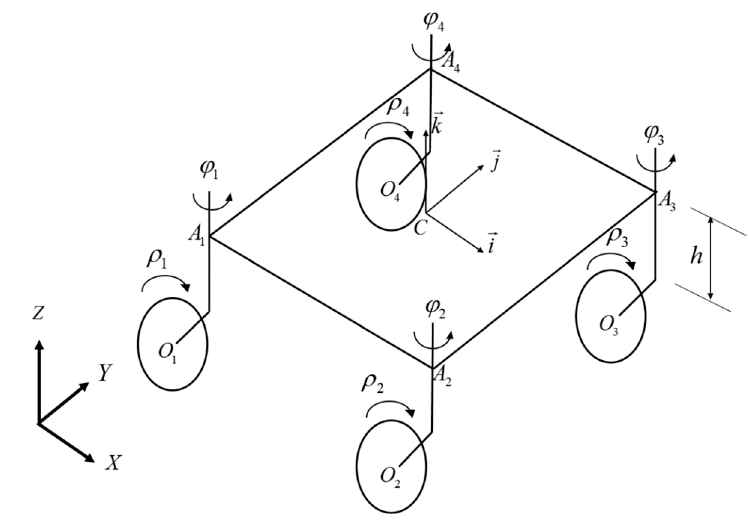
Figure 8. Structure of the OMR with four PCWs.